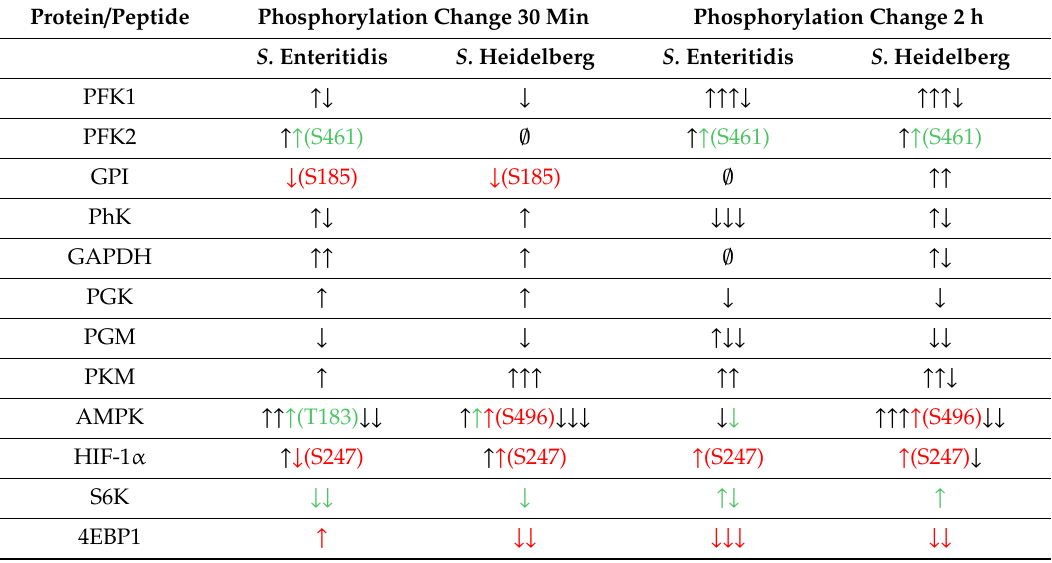
Table 3. Changes in the phosphorylation of immunometabolic peptides of S. Enteritidis and S. Heidelberg infected chicken